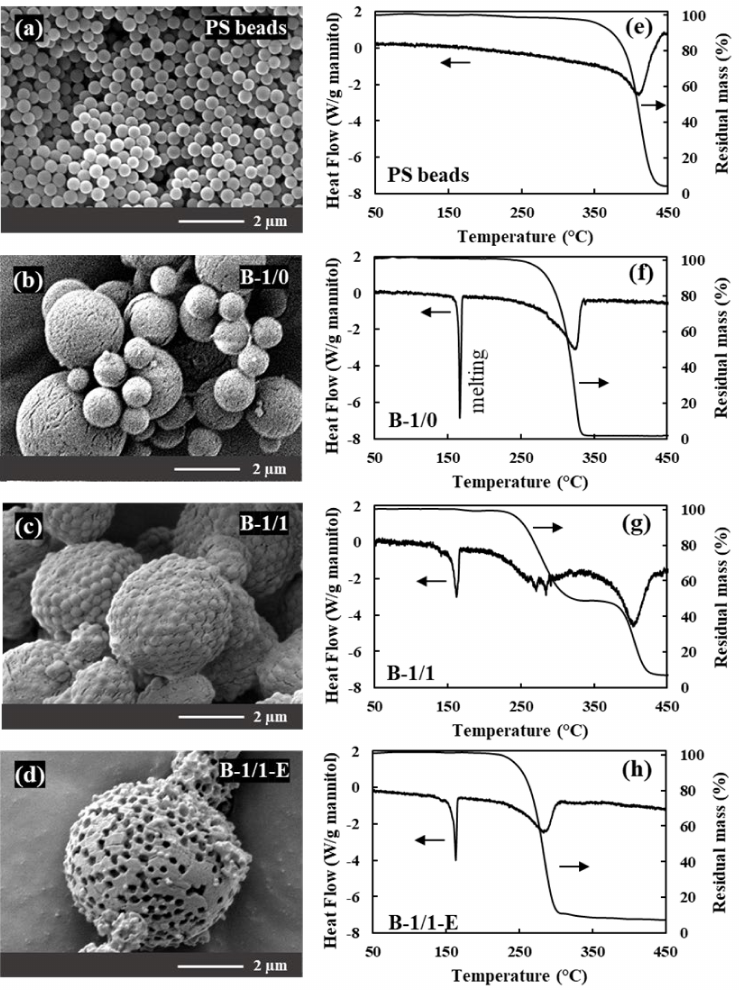
Figure 2. The SEM micrographs, TG and DSC curves (5 K/min in helium) for ( a , e ) PS beads, ( b , f ) spray‑dried mannitol (B‑1/0), ( c , g ) spray‑dried granules with a mass ratio of mannitol to PS beads of 1:1 (B‑1/1) and ( d , h ) the same granules after etching in ethyl acetate (B‑1/1‑E). The spray‑dried samples shown in this figure were obtained with the lab‑scale Büchi spray